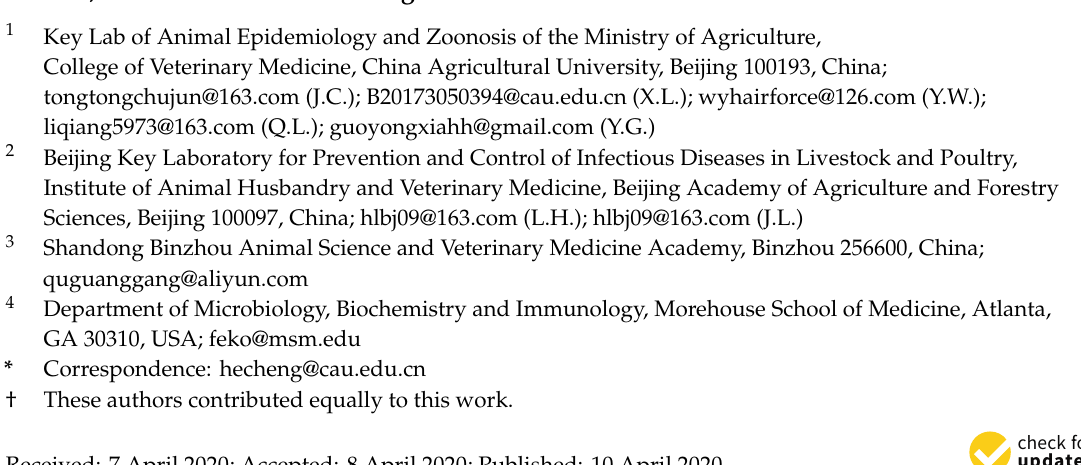
Figure 1. Construction of pEGFP-N1- pmp D-N plasmid and detection of PmpD-N expression. ( A ) The pmp D-N gene was amplified from genomic DNA of C. psittaci 6BC by PCR. M: Marker (MD103); 1: Negative control; 2: pmp D-N gene (1161 bp). ( B ) The amplified pmp D-N gene was inserted into the pEGFP-N1 vector to generate pEGFP-N1- pmp D-N. ( C ) The pmp D-N genes were expressed in HD cells and identified by RT-PCR assay. M: Marker (MD103); 1: DNA product of pEGFP-N1- pmp D-N plasmid transfected into HD11 cells; 2: RNA product of pEGFP-N1 plasmid transfected into HD11 cells. ( D ) The PmpD-N protein was detected by Western blotting analysis. Figure 2. The e ff ect of PmpD-N on chlamydial load, phagocytic function, and nitric oxide (NO) production in the HD11 cells after treatment with PmpD-N or pEGFP-N1- pmp D-N. ( A ) The data showed the mean number of chlamydial inclusion forming units (IFU) for each group. ( B )